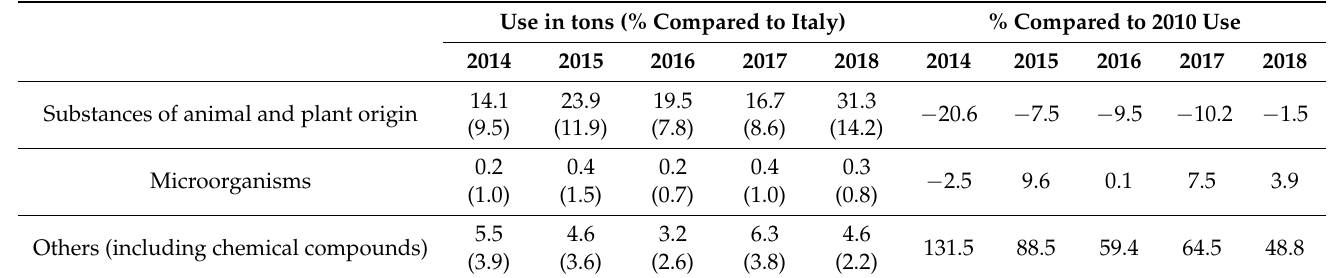
Table 1. Use (in tons) of biological active substances for crop protection in Lombardy from 2014 to 2018 (data from [25–29]). The percentage respect to the Italian use is reported within brackets. Moreover, the percentage of variation in the use compared to the year 2010 is shown. Use in tons (% Compared to